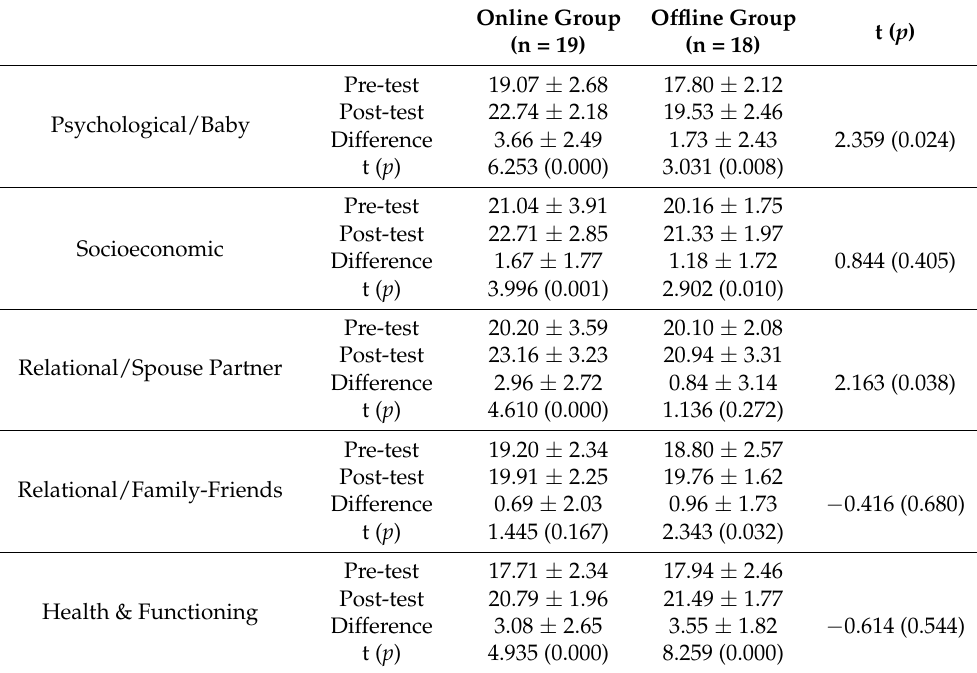
Table 5. Changes in Maternal Quality of Life (points) (N =